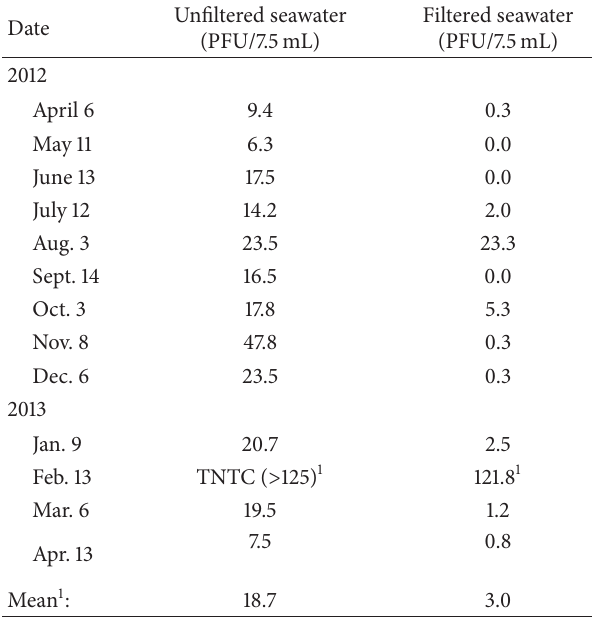
Table 2: Comparison of Bacteriovorax levels in unfiltered versus 0.45 𝜇 m filtered Hawaiian seawater. Each monthly count is the mean of six replicate assays.